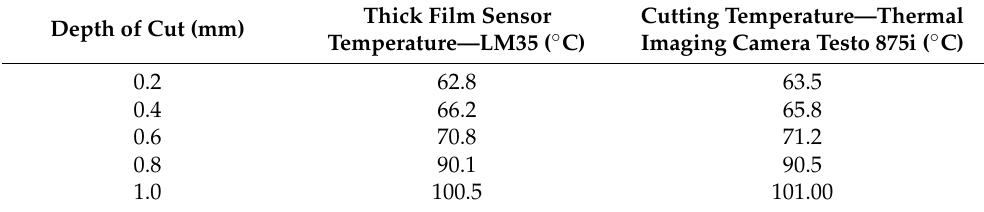
Table 7. Temperature measurement